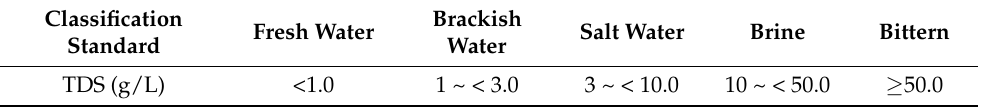
Table 1. Classification standard of water